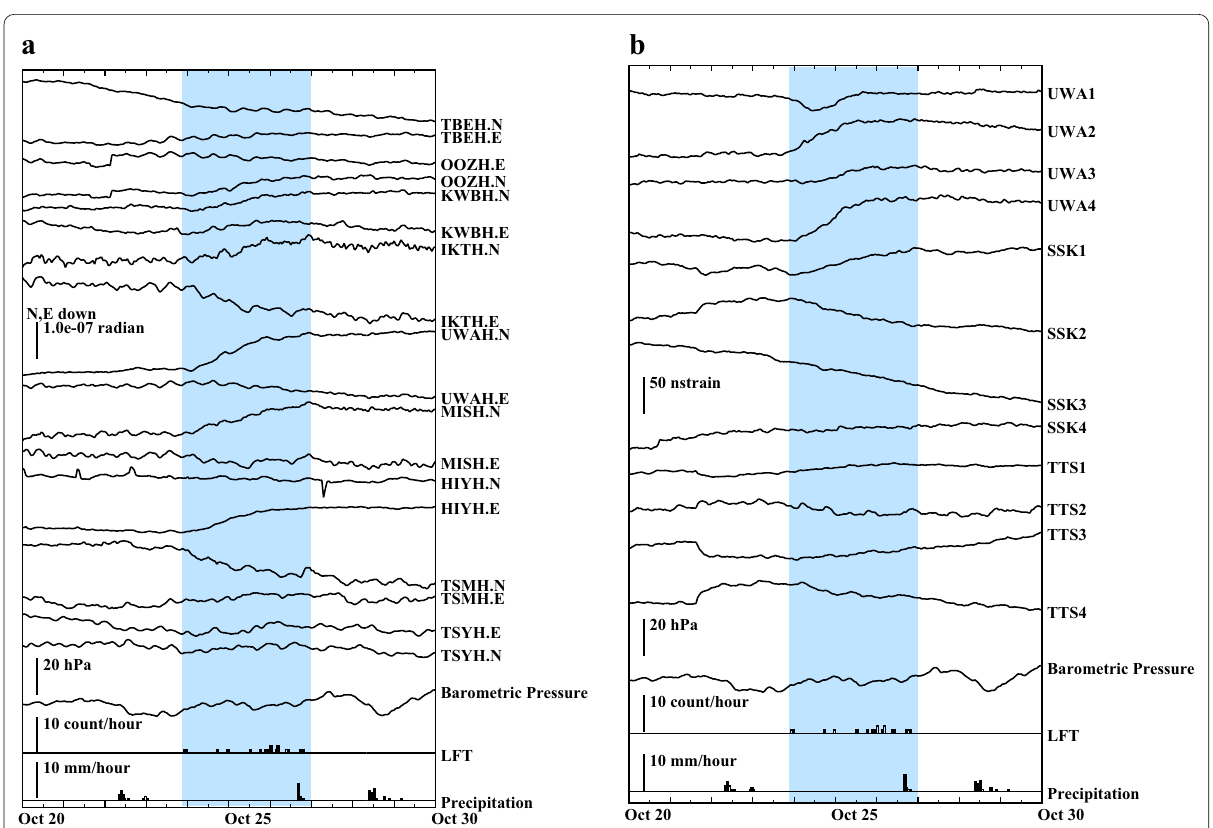
Fig. 16 Time series of a corrected tilt data and b corrected strain data for 20–29 October 2016. Also shown are numbers of LFTs per hour and barometric pressure and precipitation data from Matsuyama weather station. Linear trends have been removed from the original strain and tilt data. Data from the period in blue (2100 on 23 October–27 October) were used to estimate slip distributions in this